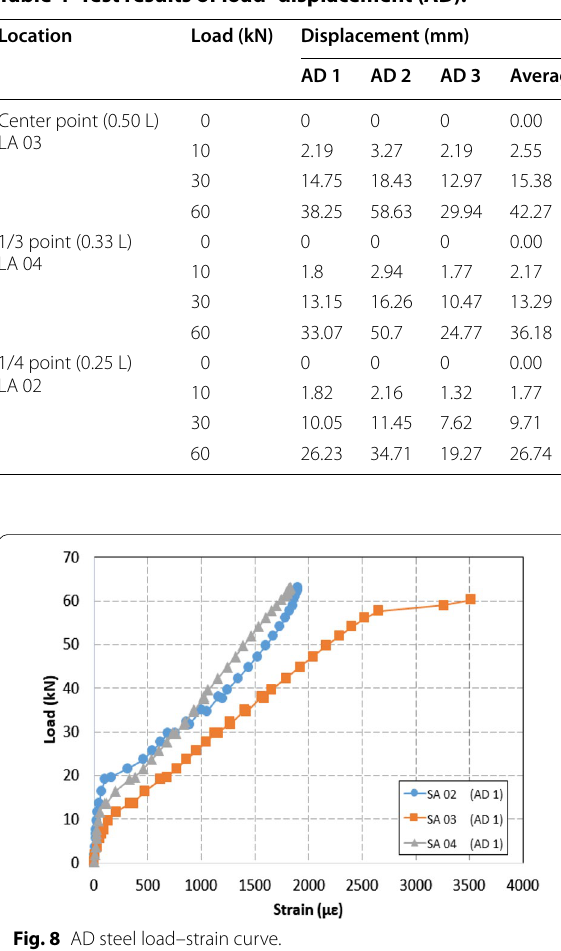
Table 5 Test results of load–steel strain data